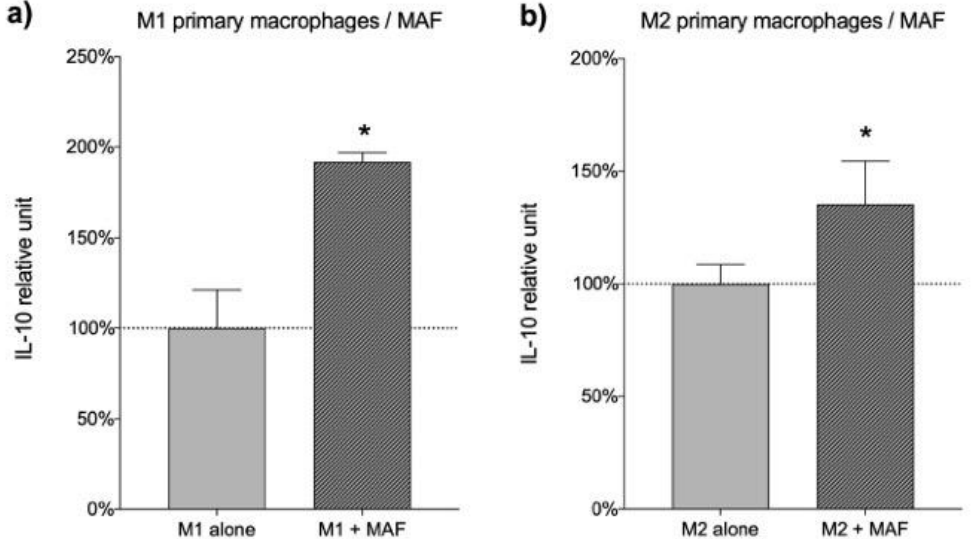
Figure 6. Effect of MAFs on IL-10 secretion in primary macrophages from healthy donors. Relative IL-10 concentration of MAF/M1-like ( a ) and M2-like ( b ) differentiated primary macrophage co-culture compared to monoculture, n = 3. Error bars represent means ± s.e.m. * p < 0.05.